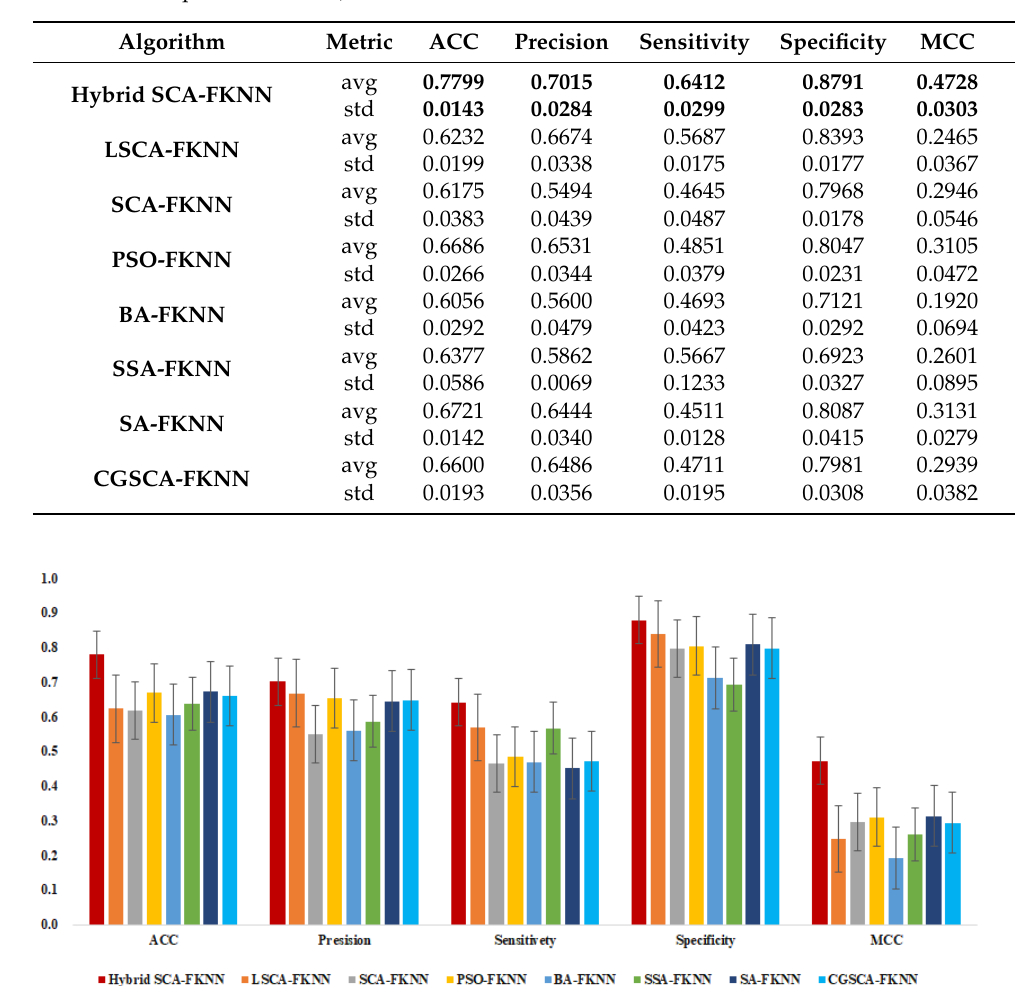
Table 4. Results of the hybrid FKNN and comparison models on the Bupa dataset. (Bold indicates the best in comparison method).